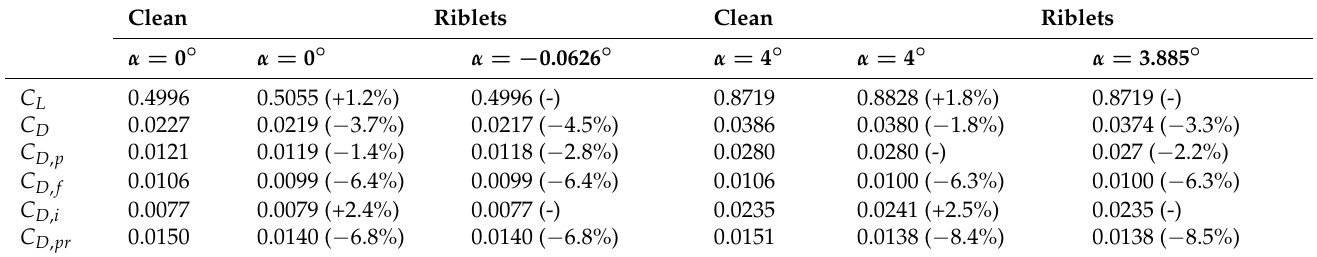
Table 1. Aerodynamic coefficients for the isolated UAV wing. Comparison between clean and riblets configurations is carried out at the same angle of attack and at the same lift coefficient for nominal angle of attack of α = 0 ◦ and α = 4 ◦